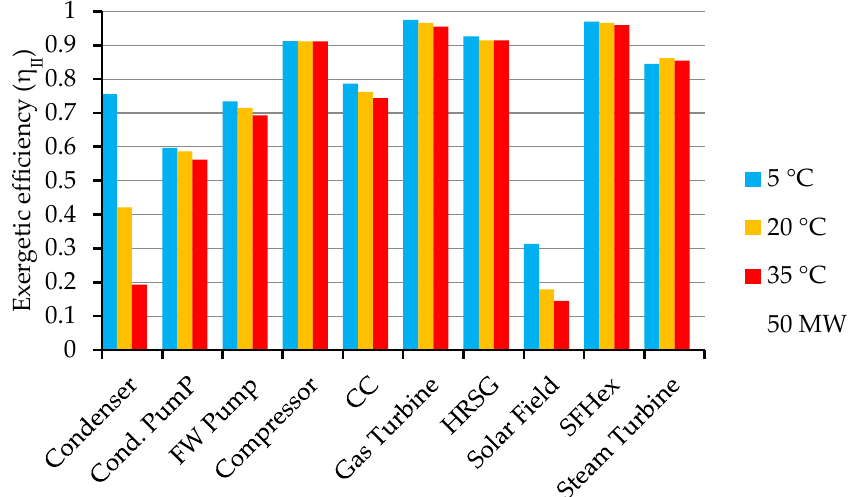
Figure 7. Exergetic efficiency of different components of the ISCC at different ambient temperatures for solar heat input equal to 50 MW.